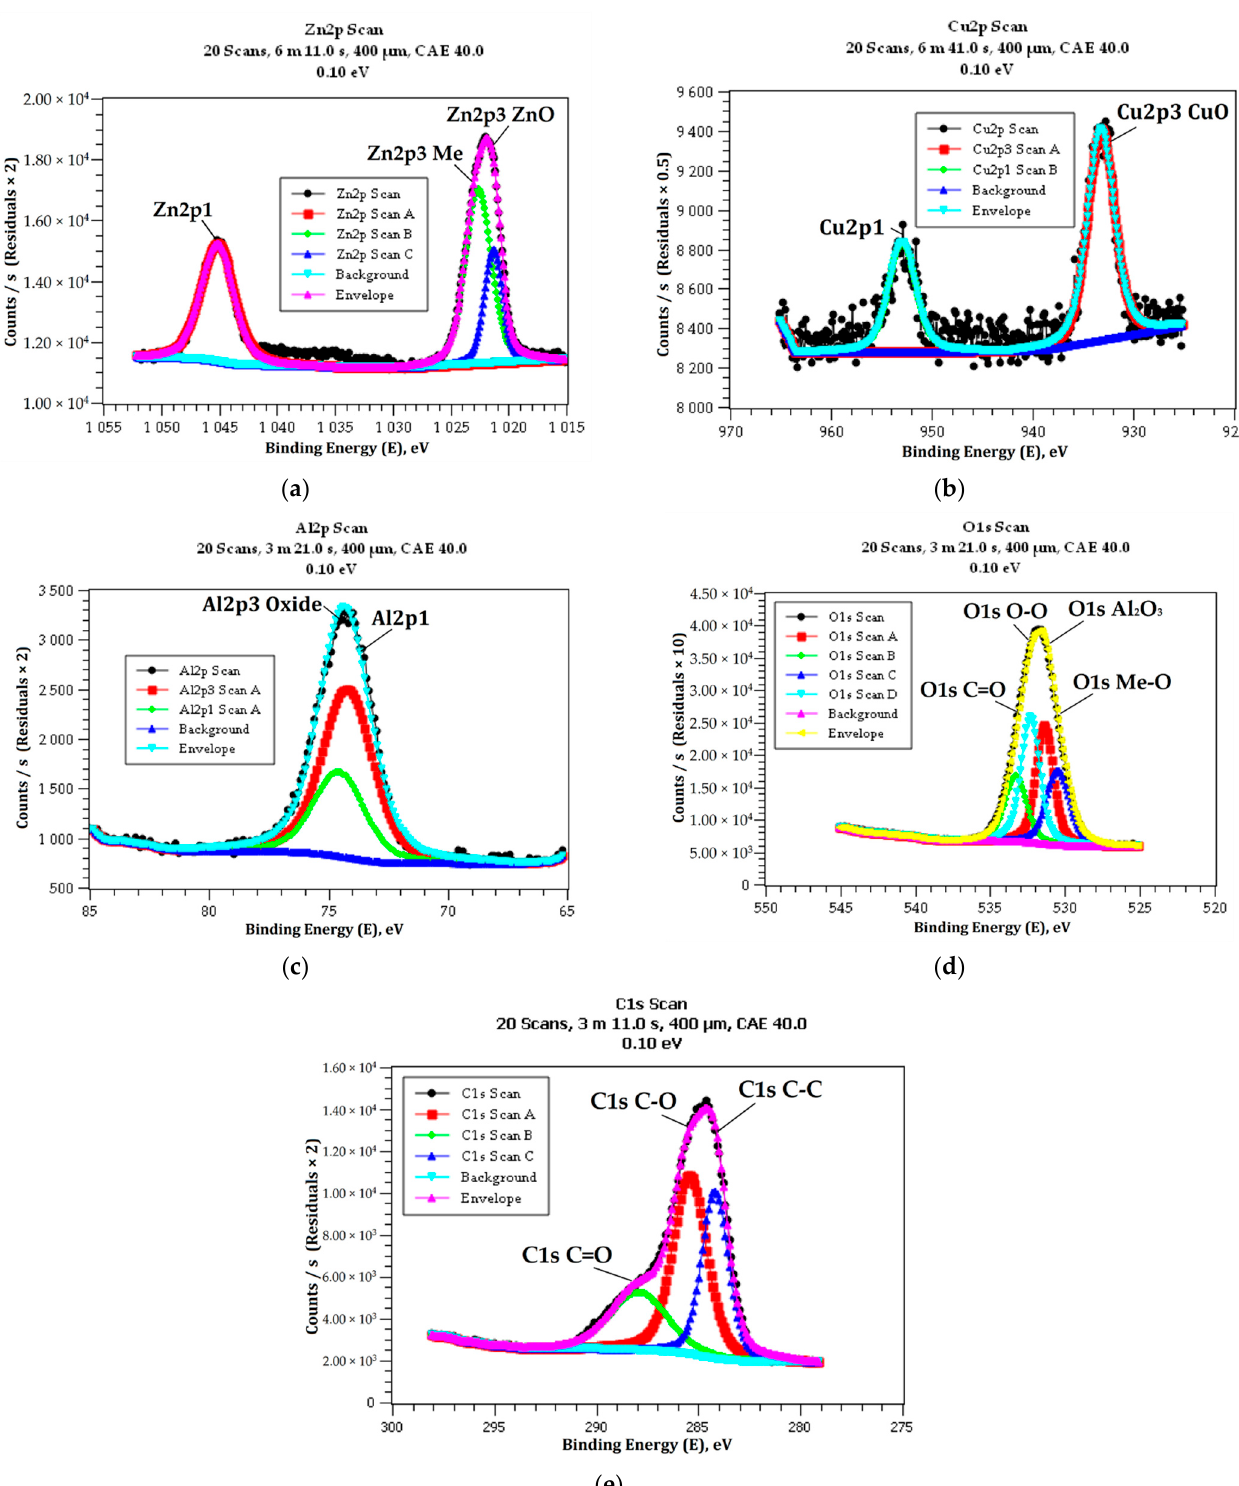
Figure 9. X-ray photoelectron spectroscopy of 2024 (D16) duralumin specimens after wire electrical discharge machining with a brass tool electrode in water medium: ( a ) zinc; ( b ) copper; ( c ) aluminum; ( d ) oxygen; ( e ) carbon. Both samples show metallic Zn and copper oxide samples responsible for metallic grey and black sediment on the machined surfaces (Figures 8a,b, and 9a,b). Zn is bound in oxide (usually matte white film) (Figures 9a) at the duralumin sample. The quantity analyses confirmed their slight presence of wire tool electrode material (less than 4 at %).